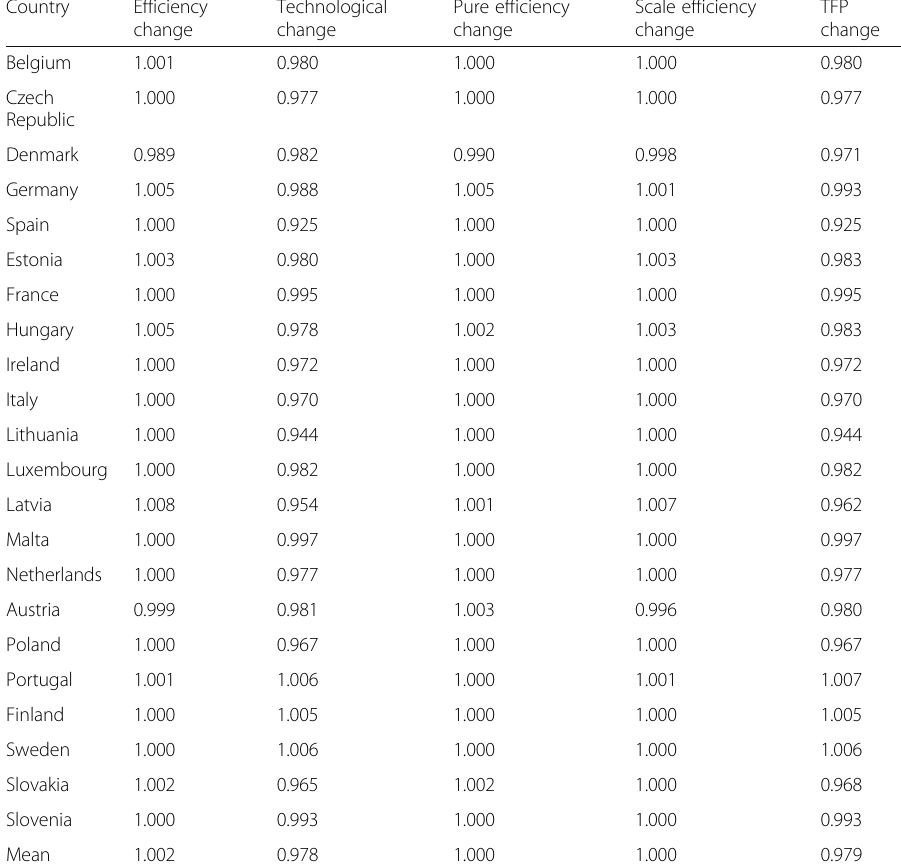
Table 5 Estimation of total factor productivity change and its components — 2004 – 2012 Country Efficiency Technological change change